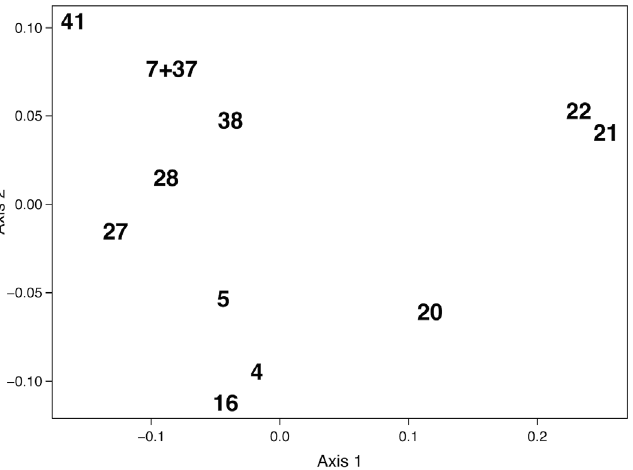
Fig 8. Multidimensional scaling of Nei's genetic distances. Genetic data from Highton and MacGregor (1983). Populations numbers match Fig